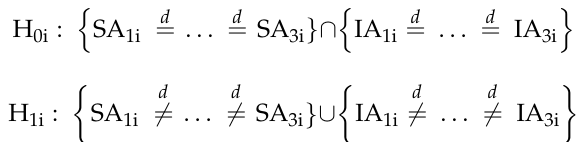
Figure 4. Boxplots of standardized rates of IA (2016–2020).